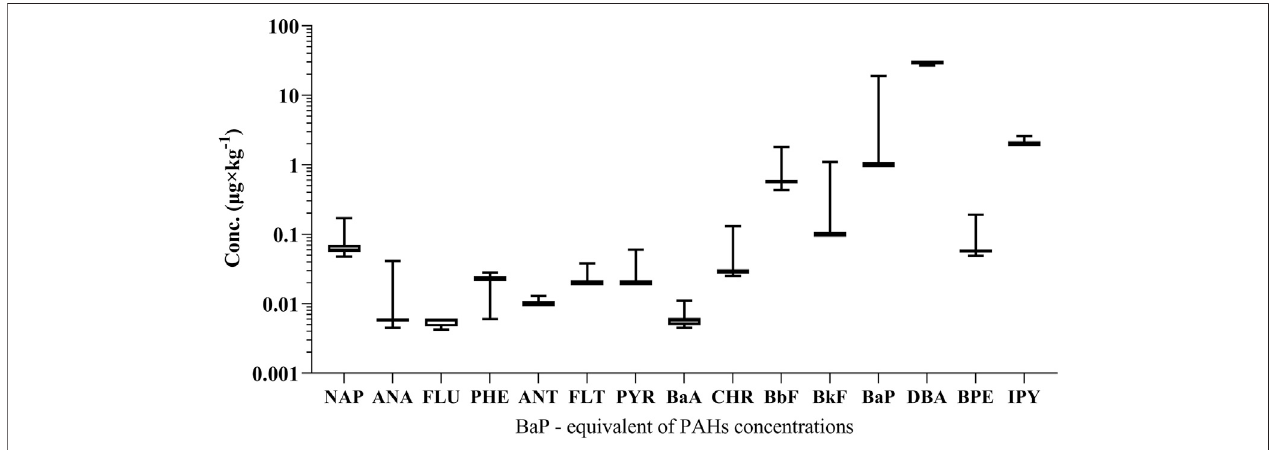
FIGURE 4 | PAHs concentrations in BaP – equivalent, μ g × kg − 1 .